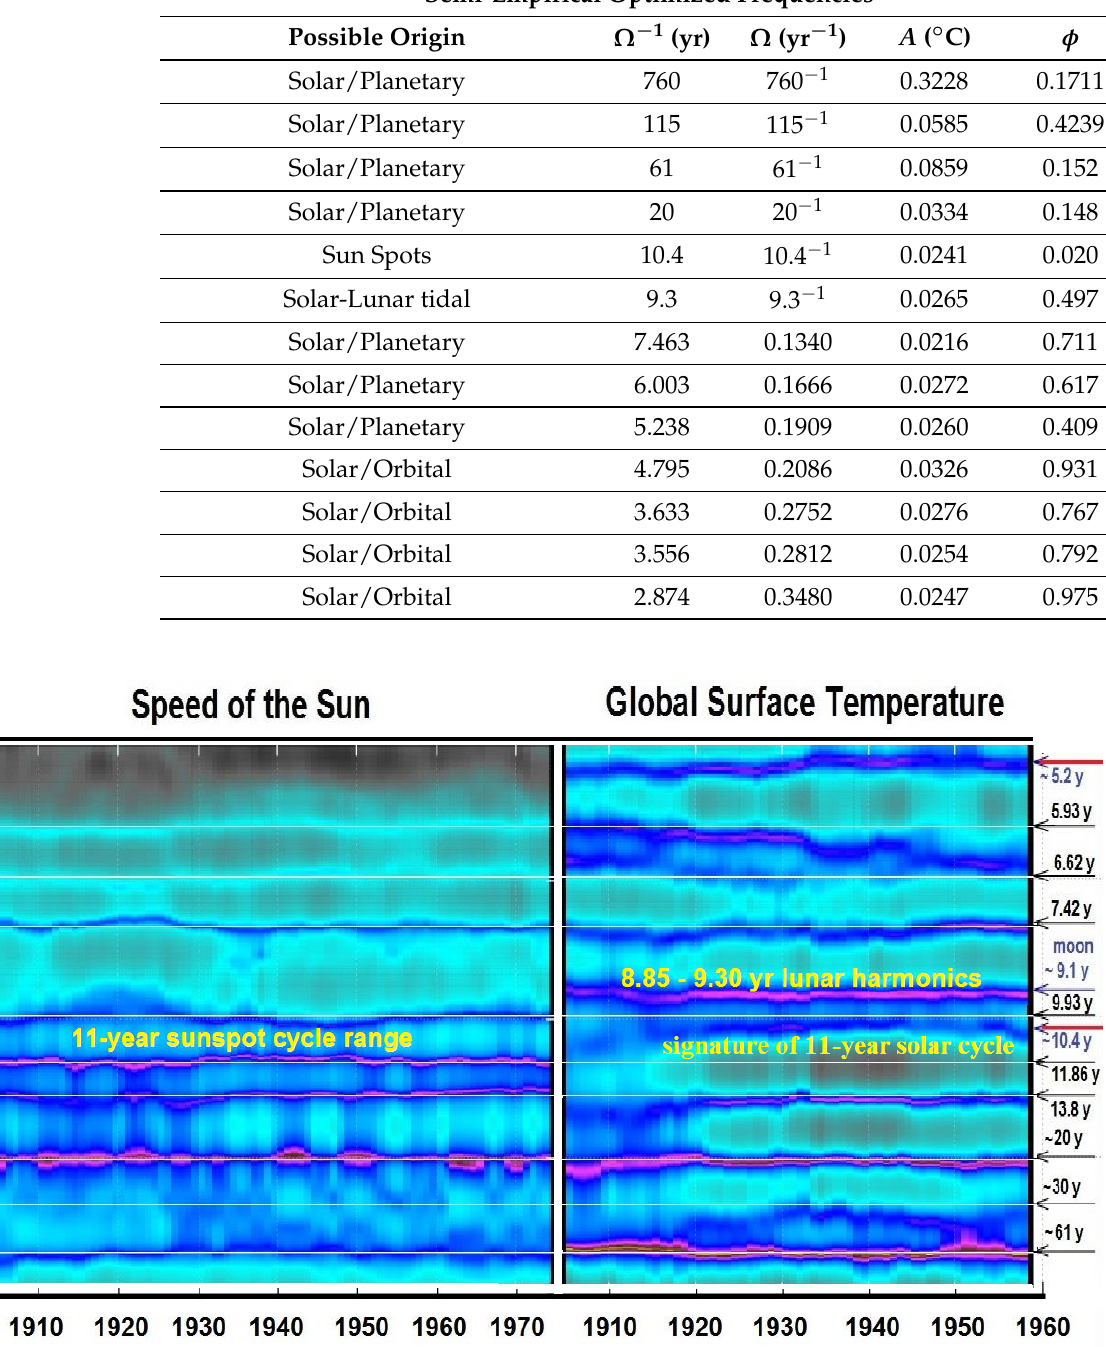
Table 3. The harmonic parameters of the astronomically optimized semi-empirical model. Here the 6 frequency and phases of the decadal to millennial harmonics were substituted with the theoretical values deduced from astronomical considerations. About the millennial cycle note that 760 year is not its period, see the full equation is Equation (7) and the explanation in the text. For the probable physical origin of the oscillations see Refs. [84–86,106].